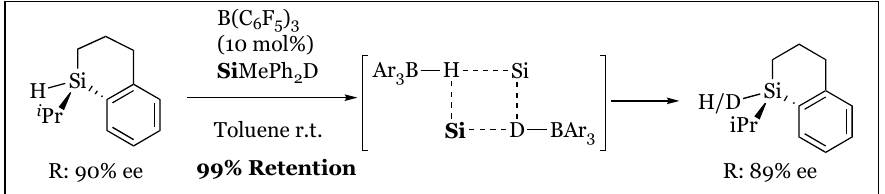
Figure 36. Walden inversion observed in the conversion of the R to S enantiomer of the silane stereocenter in the hydrosilylation of acetophenone.